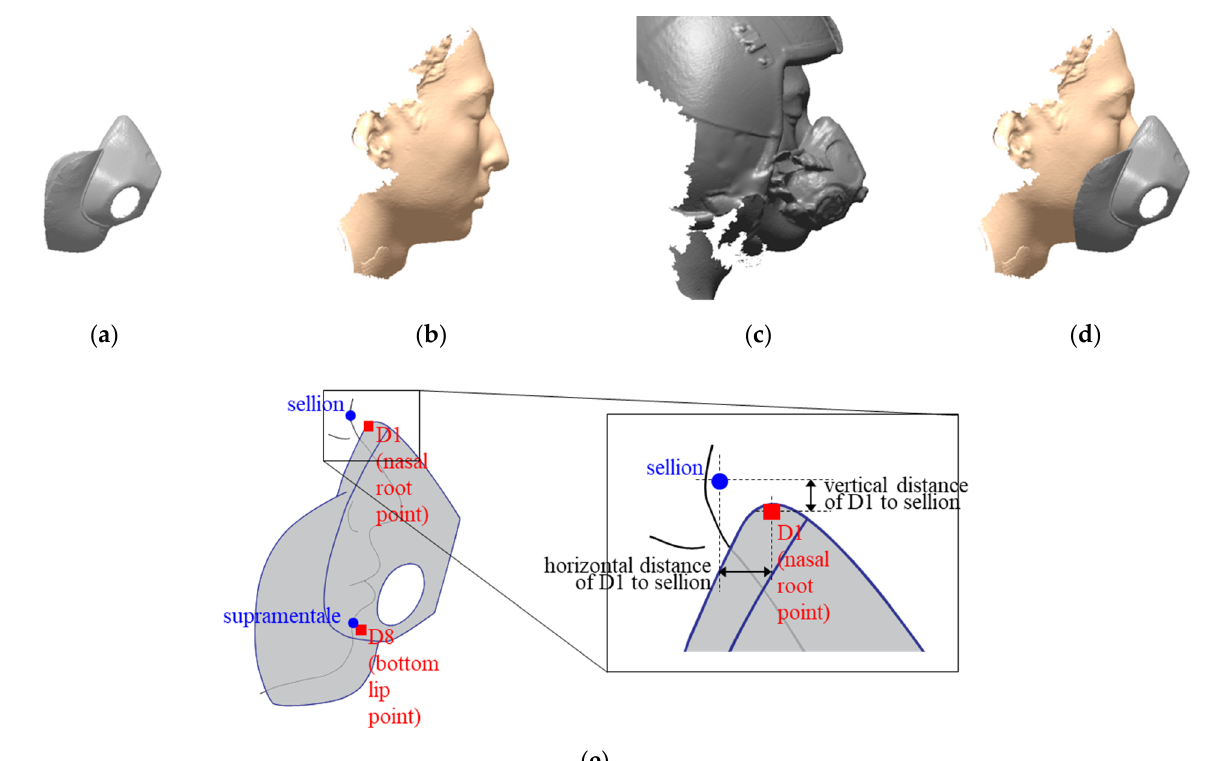
Figure 2. Identification of mask-wearing positions using 3D scan images of a pilot face and an oxygen mask (illustrated). ( a ) 3D scan image of an oxygen mask; ( b ) 3D face scan image without wearing the mask; ( c ) 3D face scan image wearing the oxygen mask; ( d ) 3D scan images of the mask and the face overlaid to the 3D face scan image wearing the mask; ( e ) identification of the mask-wearing positions based on the mask design landmarks ( ■) and facial landmarks ( ⬤ ).